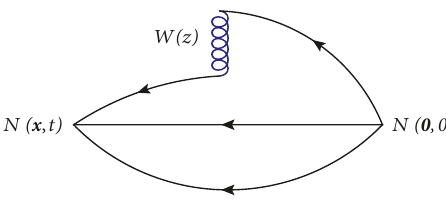
Figure 10: Diagram representing the three-point correlation func- tion that needs to be evaluated to calculate quasi-PDFs. Source: arXiv version of [124], reprinted with permission by the Authors Attribution 4.0 International